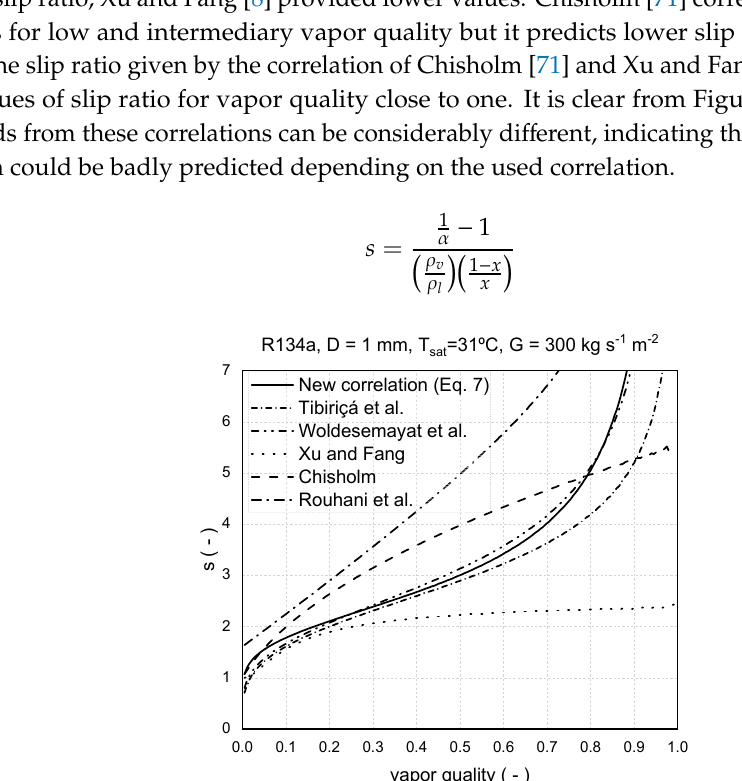
Figure 10. Comparison between the slip ratio calculated with the new correlation and the best ones observed from the literature.